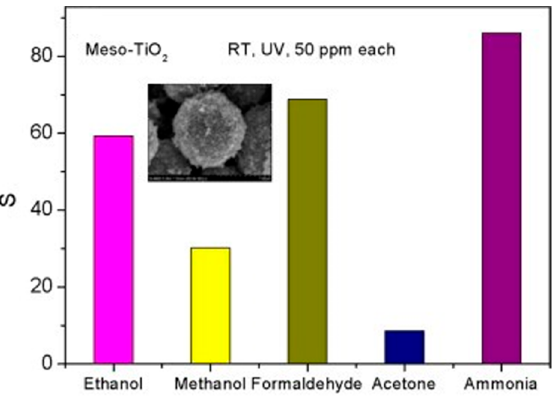
Figure 37. Formaldehyde response of microporous TiO 2 at room temperature in various background gases. Reproduced with permission from [65].